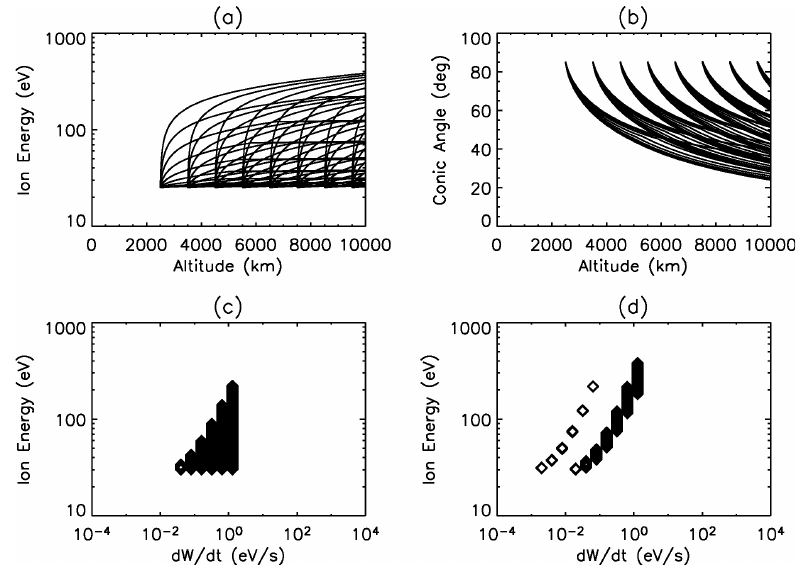
Fig. 8. Variations in energy (a) and conic angle (b) of each ion as a function of altitude and statistical summary of ion energy of perp. (c) and non-perp. (d) conics as a function of heating rate observed at altitudes between 5000 and